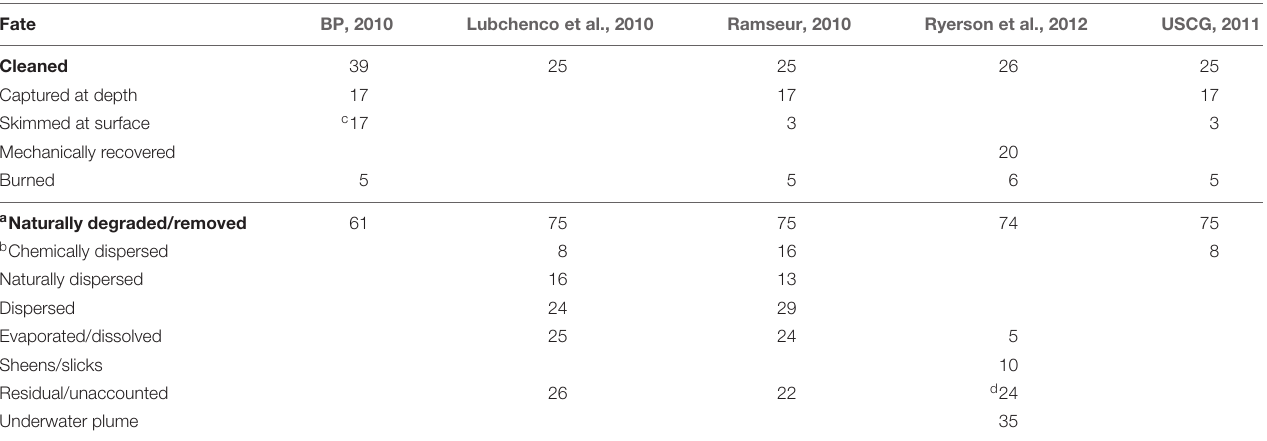
TABLE 1 | The estimated values for the fates of oil (% of total) released during the Deepwater Horizon oil spill in 2010.